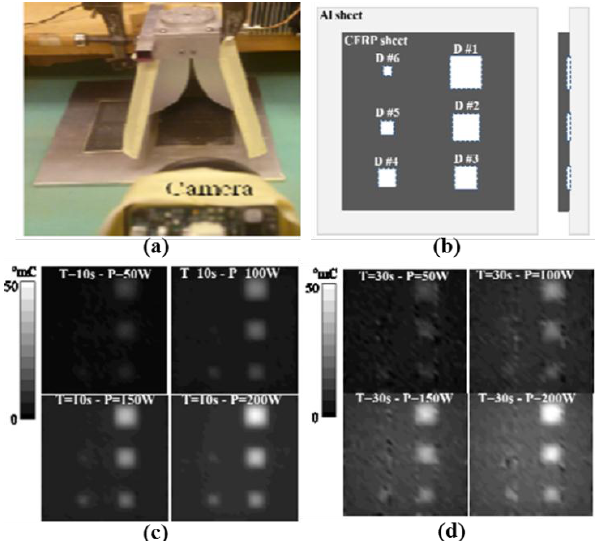
Figure 18. MWT experimental setup ( a ), sample ( b ), measurement results for 10 s heating ( c ) and 30 s heating ( d ) [64]. Reprinted/reproduced with permission from